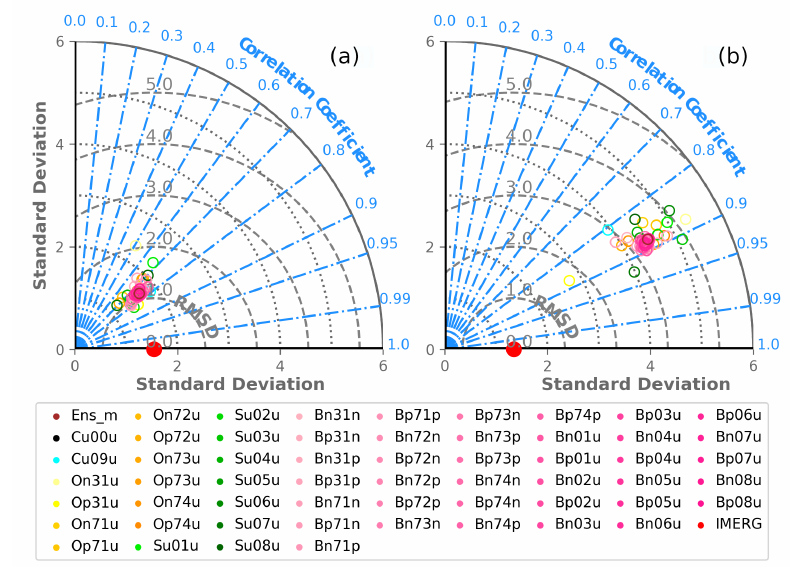
Figure 12. Taylor diagrams for precipitation computed from IMERG hourly data used as a reference. WRF data is taken from ( a ) the domain point closest to the Lopez Zamora station location, and ( b ) the point of maximum average precipitation from all members. Valid for the simulation period starting at 00Z on 27 February